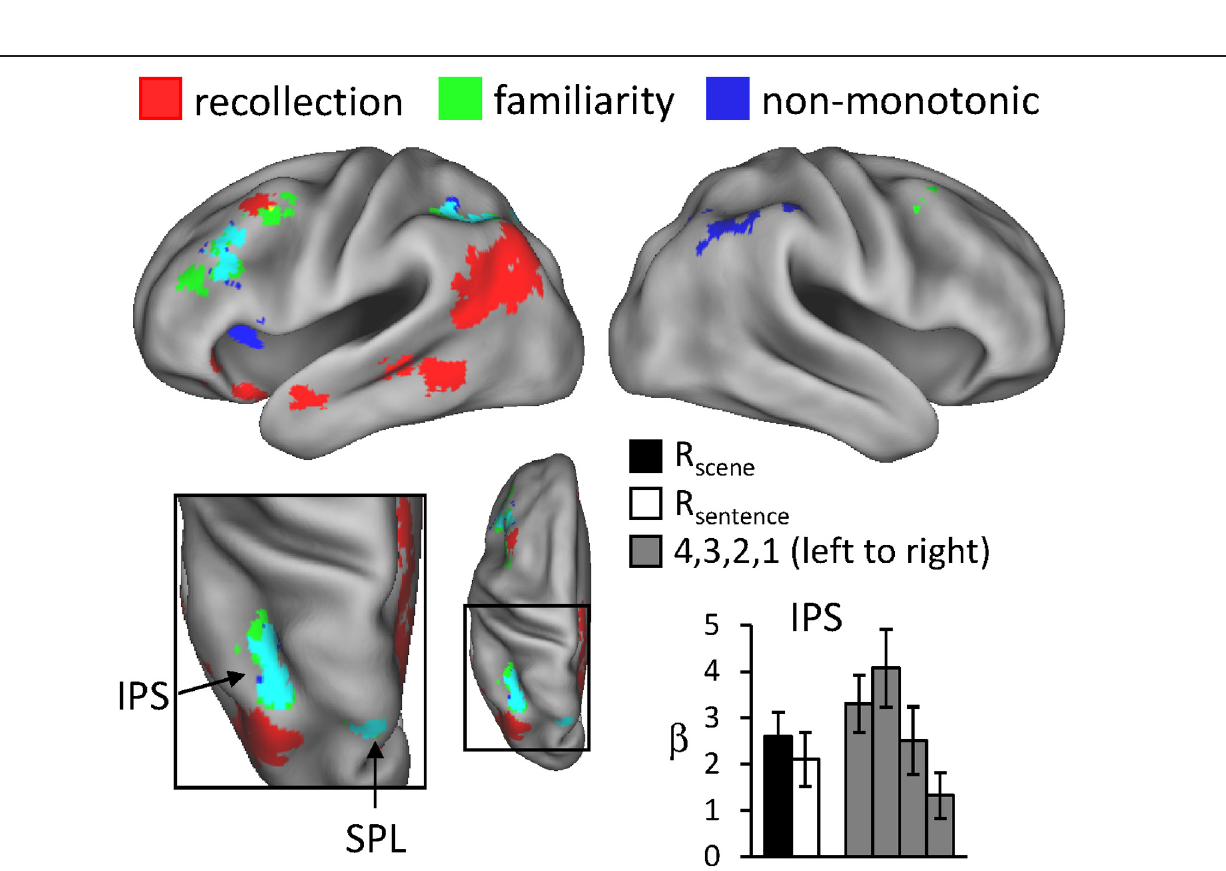
displayed. Arrows point to overlap (in cyan) of non-monotonic and familiarity effects in intraparietal sulcus (IPS) and superior parietal lobule (SPL). The histogram indicates mean parameter estimates ( β ) from the peak voxel of the monotonic effect in IPS. R (remember); 4, 3, 2, 1 (confidence